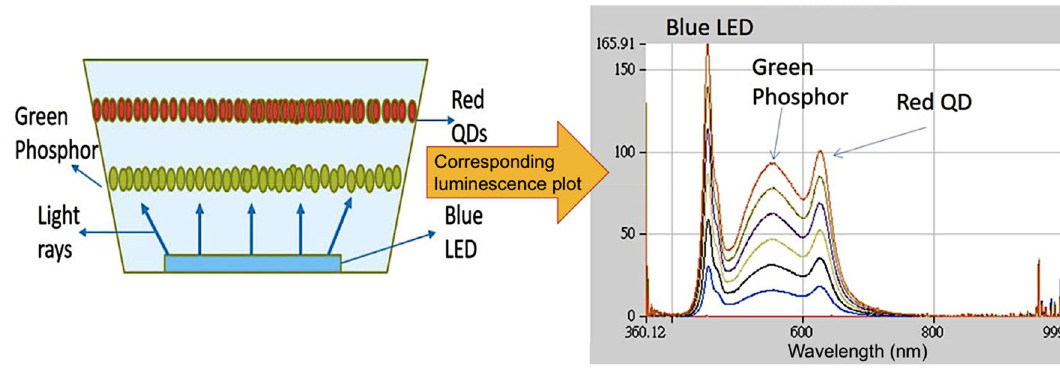
Figure 1. Schematic of LED structure and its corresponding luminescence